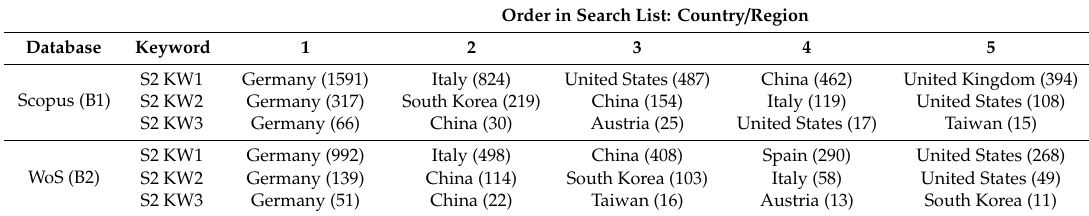
Table 9. Number of published scientific papers according to: country / region (TOP